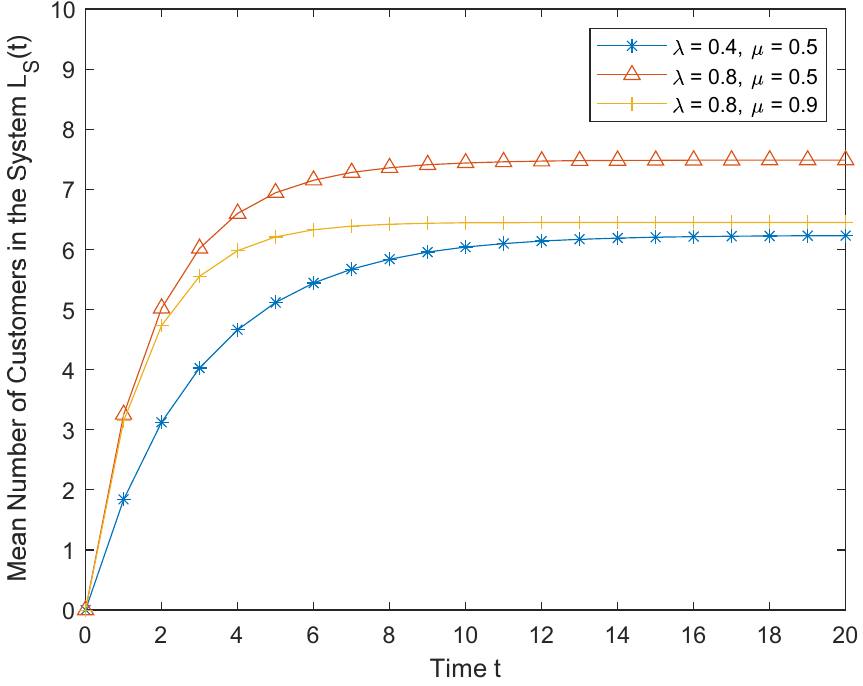
Figure 6. The mean number of customers in the system L S ( t ).